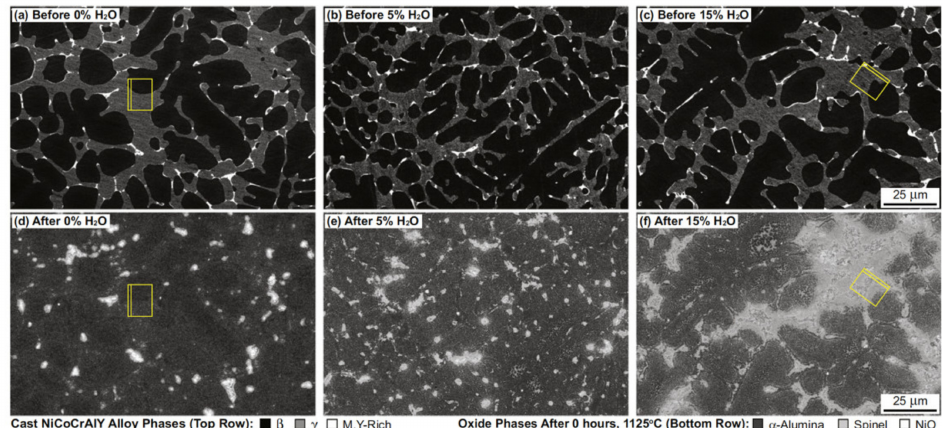
Figure 7. Before and after SEM images of cast NiCoCrAlY TGO grown in 0 vol.% H 2 O ( a ) and ( d ), 5 vol.% H 2 O ( b ) and ( e ), and 15 vol.% H 2 O ( c ) and ( f ) after thermal cycling at 1125 ◦ C